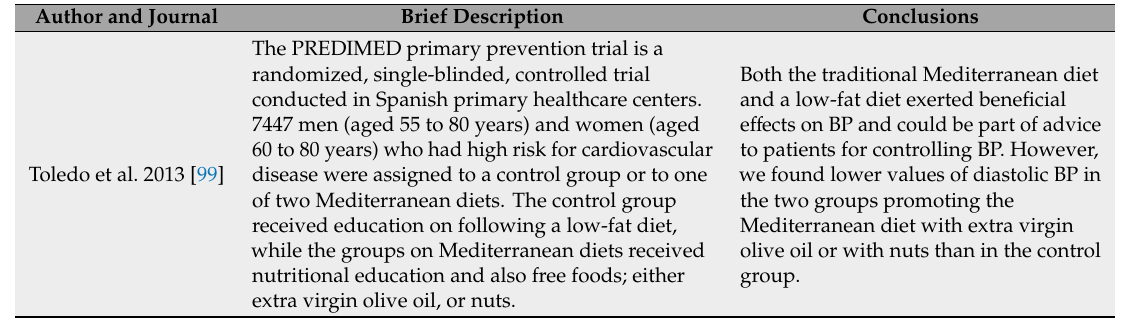
Table 2. Main studies about mediterranean diet and its e ff ects on